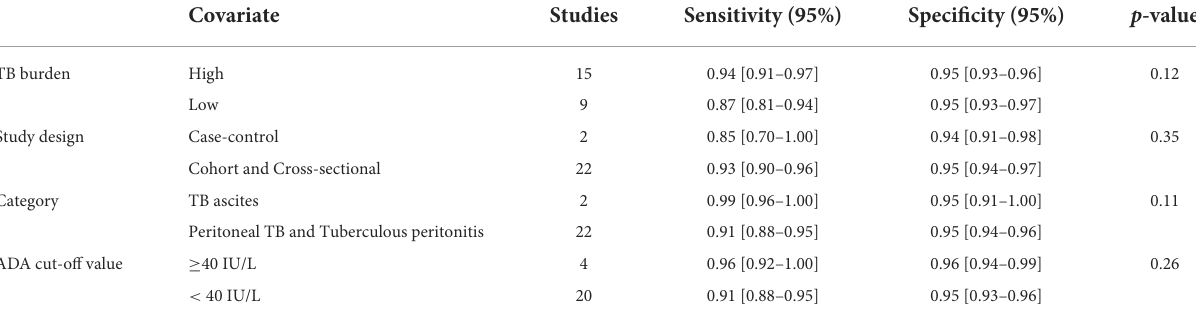
TABLE 3 Analysis of heterogeneity